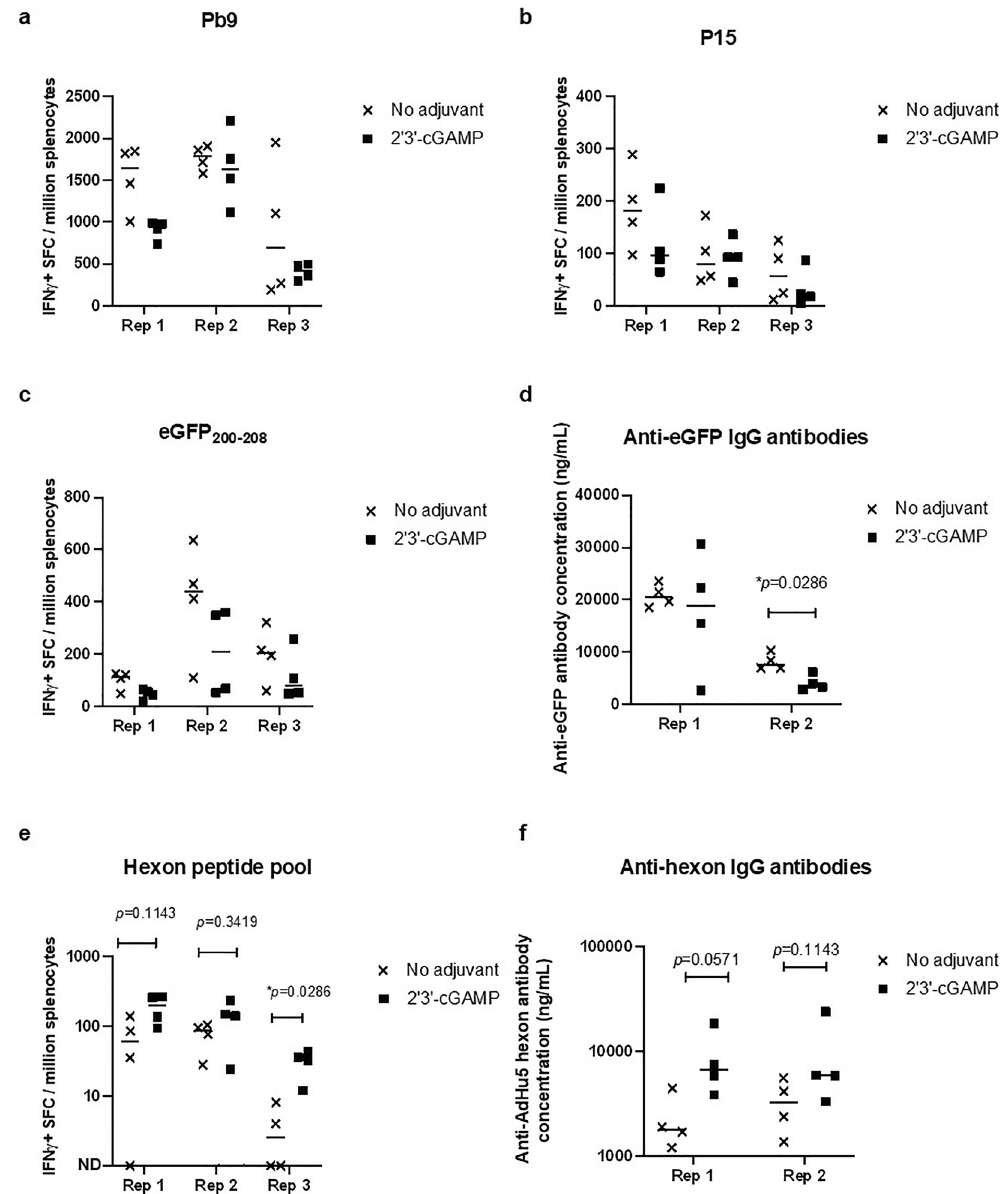
Figure 1. 2 ′ 3 ′ -cGAMP has opposing effects on AdHu5. Mice ( n = 4 per experiment) were injected intramuscularly with 10 μg of 2 ′ 3 ′ -cGAMP mixed together with 10 7 IU of AdHu5. T and B cell immunogenicity against encoded antigens and viral capsid proteins were measured 14 days after vaccination. Splenocytes were re-stimulated with Pb9 ( a ), P15 ( b ), eGFP 200-208 ( c ) and a T cell peptide pool spanning the AdHu5 hexon ( e ) and IFN-γ production measured by ELISpot. For antibody responses, serum was analyzed using IgG ELISA coating the plates with eGFP ( d ) or AdHu5 hexon protein ( f ). For each panel, Rep 1, Rep 2 and Rep 3 represent independent experiments. Black horizontal lines for each mouse group represent the group medians. Statistical analysis: Mann–Whitney test between treatments within a single experiment (no adjuvant versus 2 ′ 3’-cGAMP) (* p < 0.05). The sample sizes correspond to the initial intention of gathering evidence of the phenomena